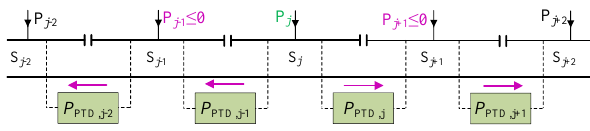
Figure 14. Transmission between two power supply sections.